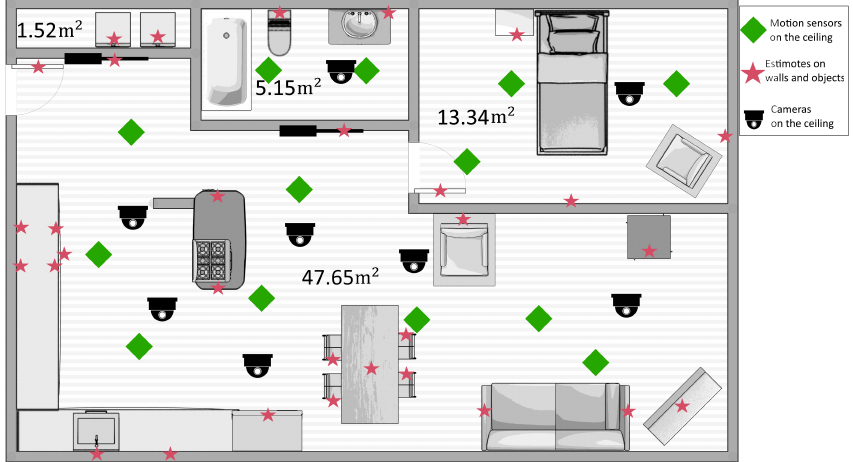
Figure 4. Layout of the SmartCondo TM with positions of static Estimote stickers and PIR motion